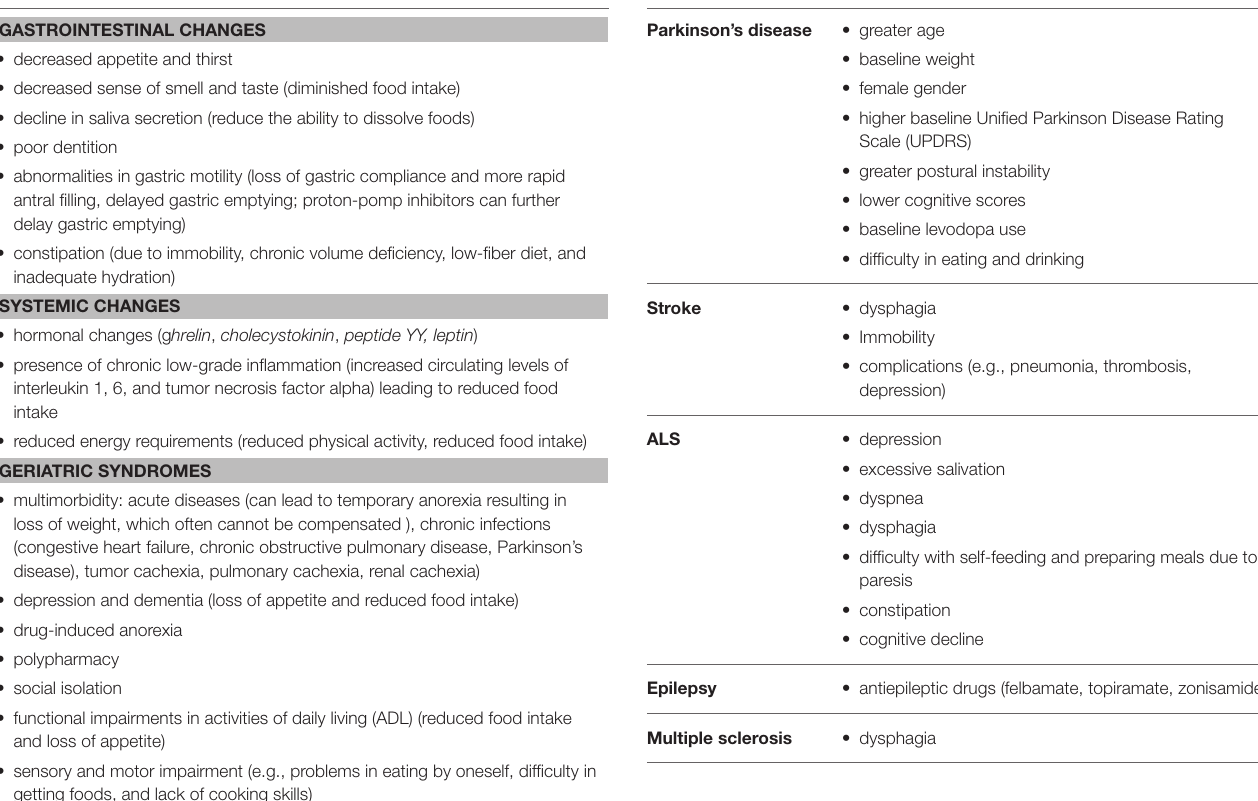
TABLE 1 | General factors contributing to anorexia of aging and malnutrition. TABLE 2 | Disease specific risk factors and predictors of